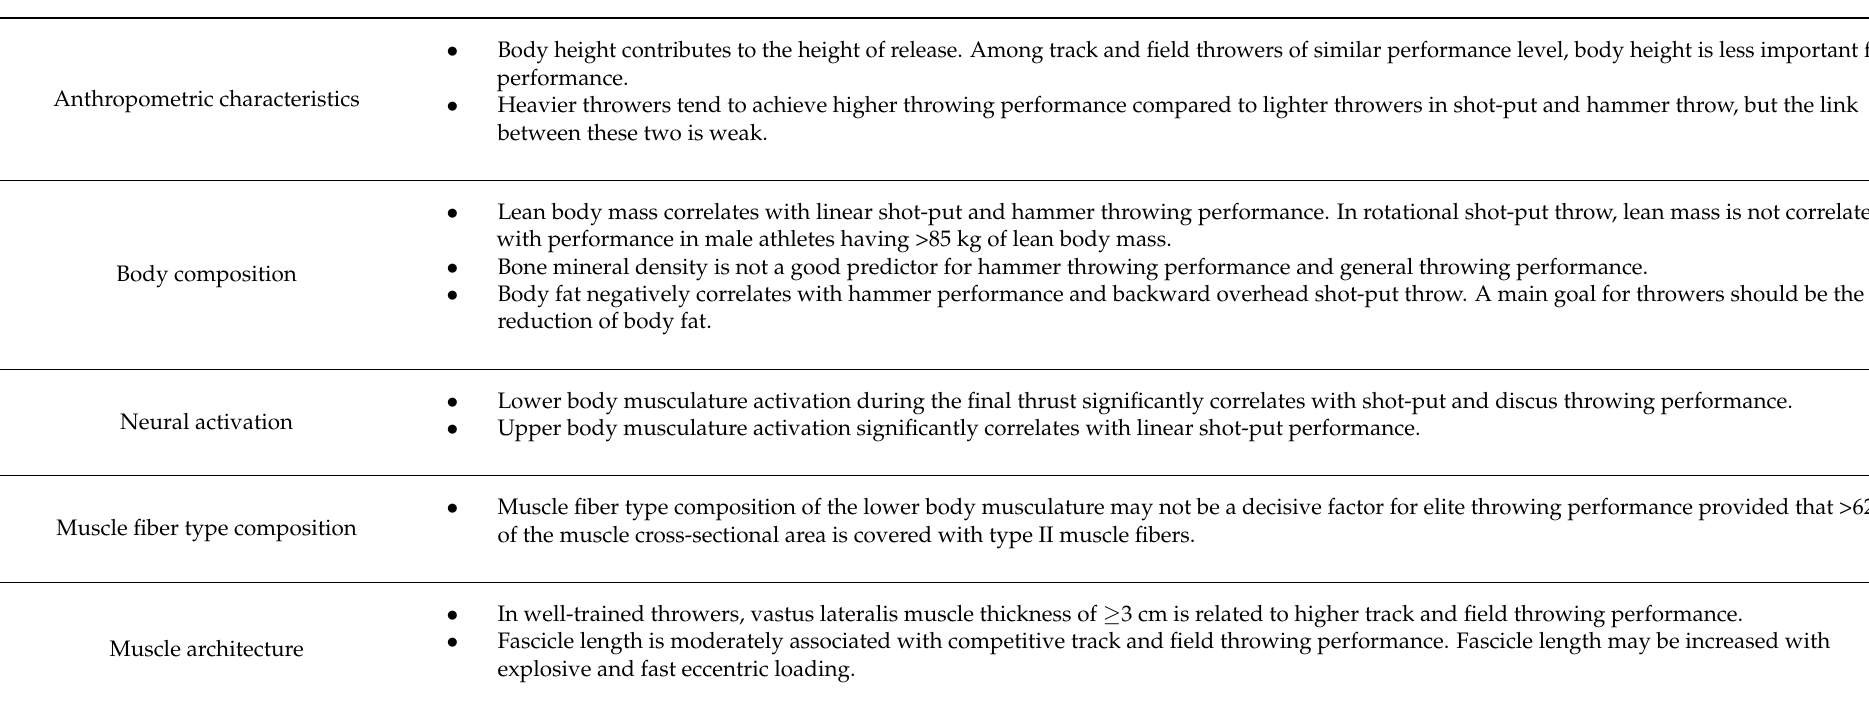
Table 5. Summary of the main findings of the